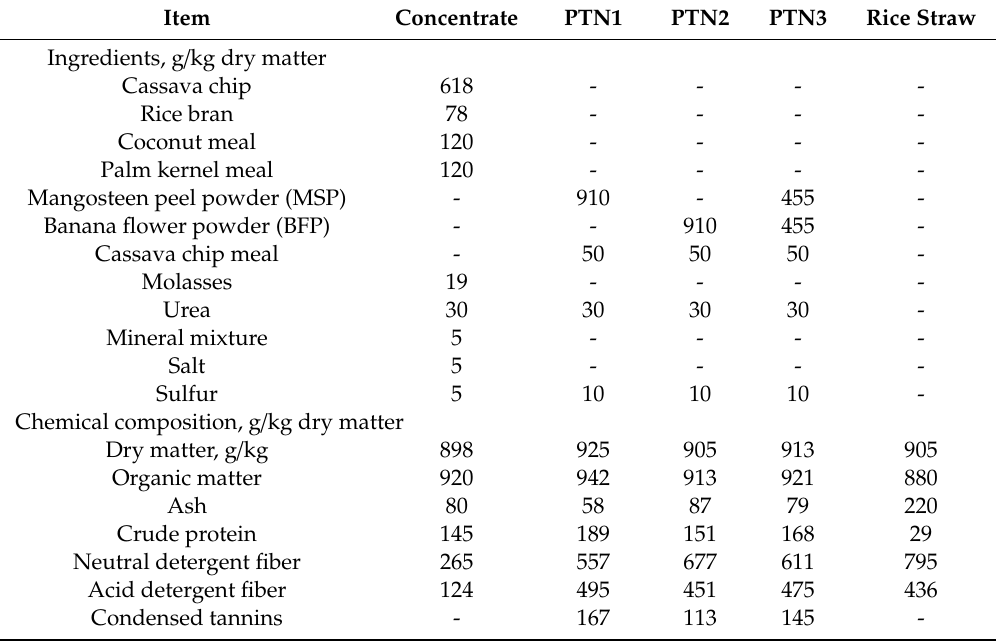
Table 1. Feed ingredients and chemical compositions of the experimental